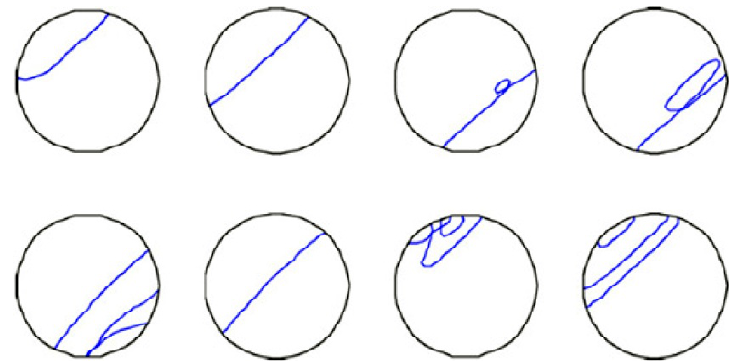
Fig. 25. Dislocation gliding along (0 1) plane in a b.c.c. pillar. The dislocation orients as a screw one and emits additional dislocations promoting strain hardening. Reprinted with permission from Greer JR,